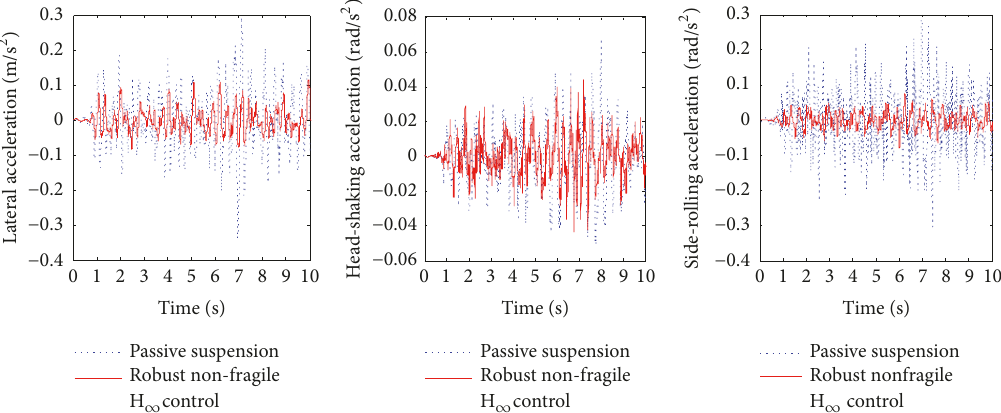
Figure 3: Acceleration time domain diagram. (a) Lateral-moving vibration. (b) Head-shaking vibration. (c) Side-rolling vibration.